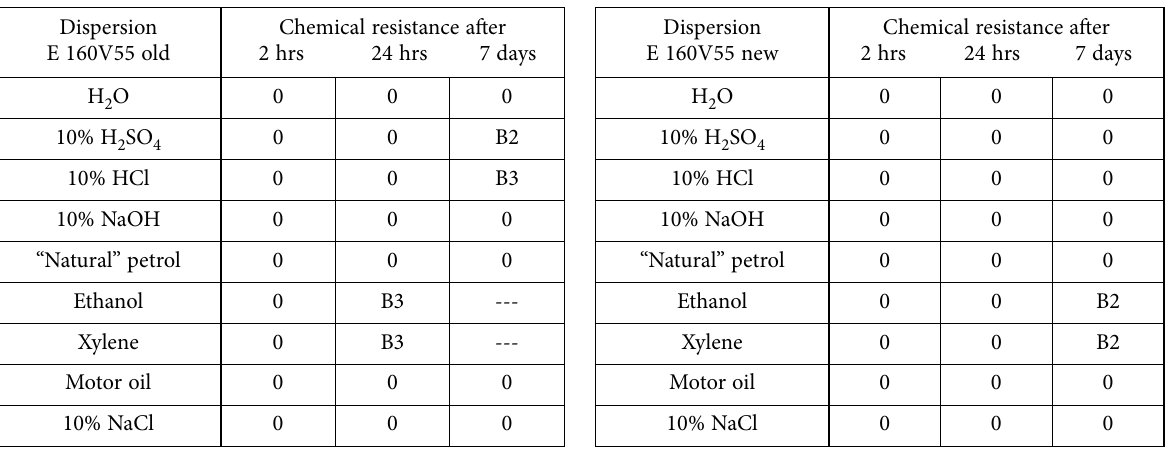
Table 5. Chemical resistance of the new dispersion film, two coats